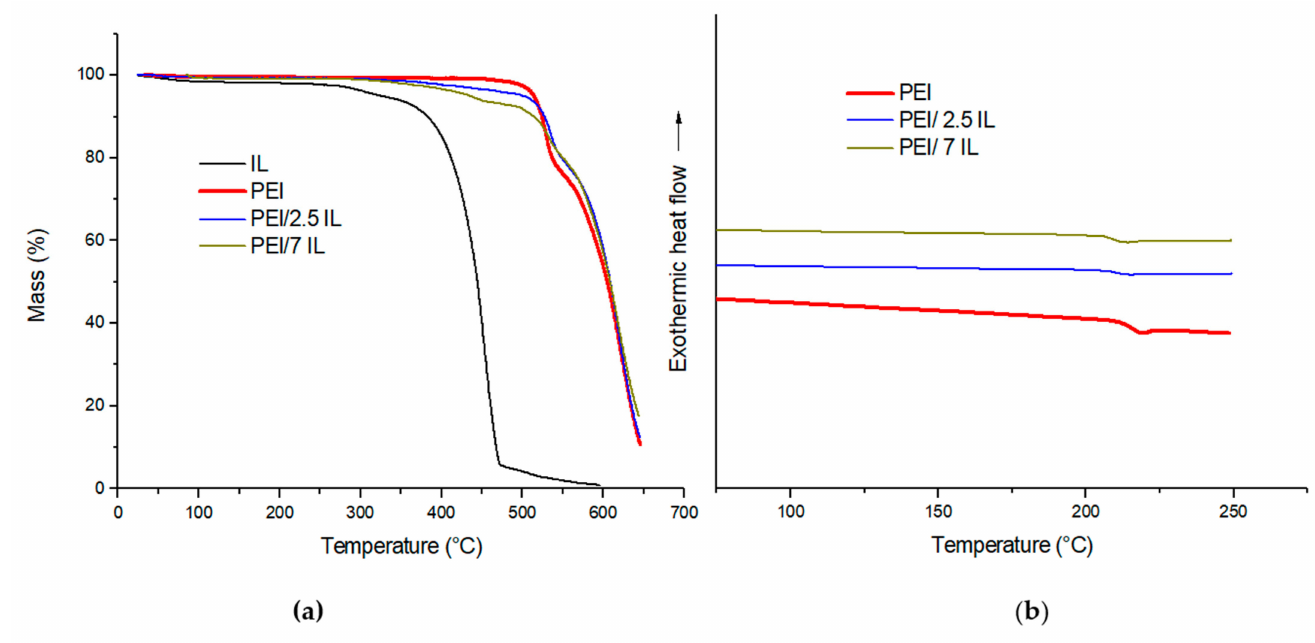
Figure 2. ( a ) TGA mass loss curves and ( b ) DSC thermograms for PEI/x IL (x = 0; 2.5;